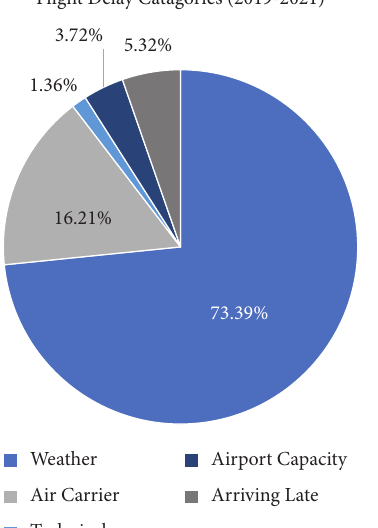
Figure 4: Flight delay categories during 2019–2021.